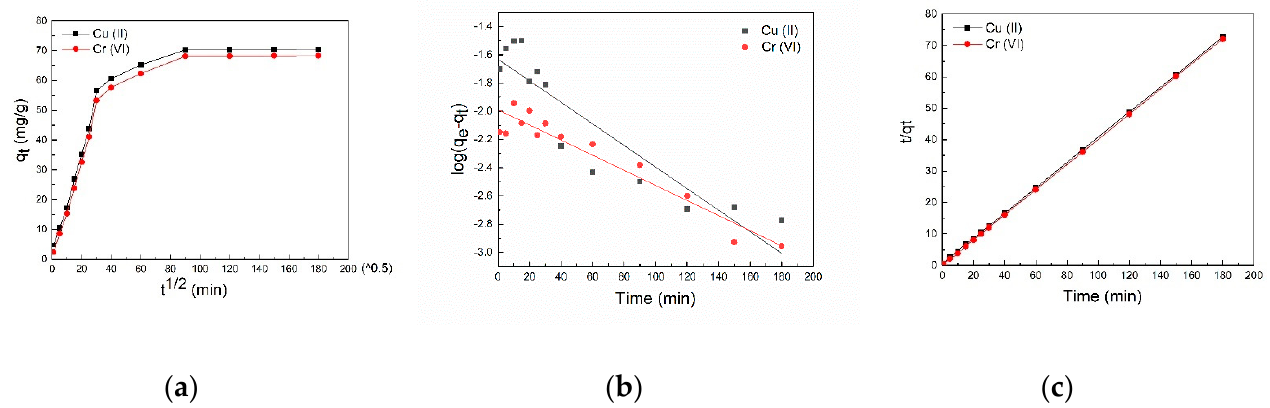
Figure 3. Intra-particle diffusion ( a ), pseudo-first-order ( b ), and pseudo-second-order kinetic models ( c ) of Cu(II) and Cr(VI) onto C-S-H.